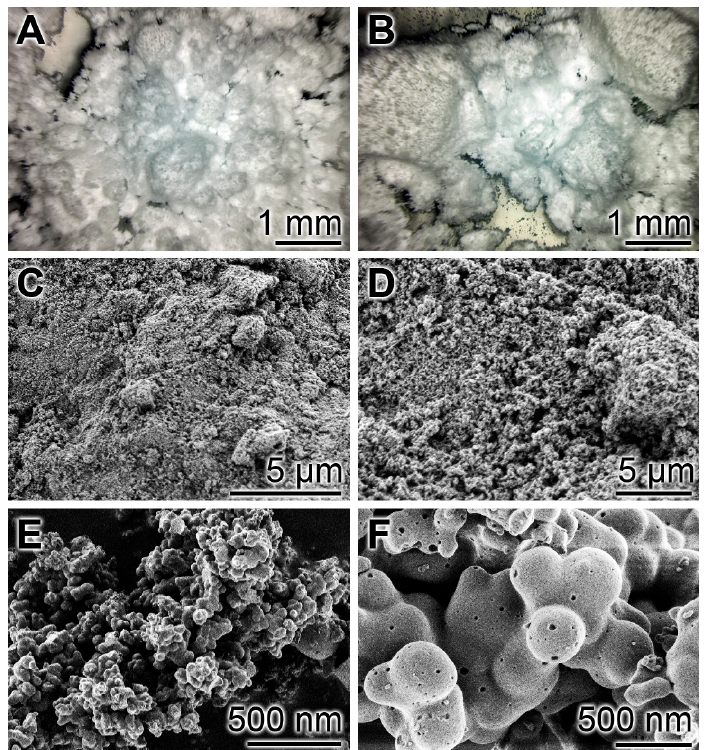
Figure 1. Micrographs of Ca-phosphate nanoparticles (Ca-phosphate-NP) and of Ca-polyP microparticles (Ca-polyP-MP); ( A , B ) optical microscopy; ( C – F ) Scanning electron microscopy (SEM) ( A , C , D ) The Ca-phosphate-NP appear as homogeneous material and as spherical particles of a size around 35 nm at high magnification; ( B , E , F ) The Ca-polyP-MP particles are a likewise homogenous powder at lower magnification and spherical particles at high power scanning electron microscopy (SEM).